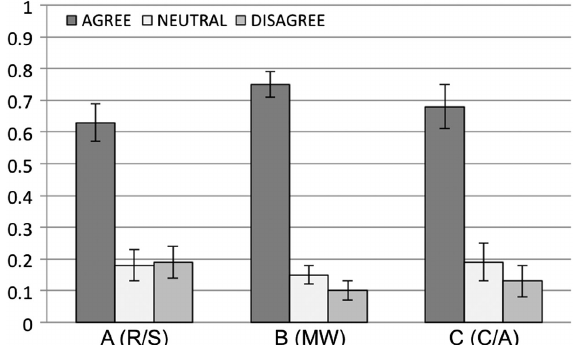
FIG. 6. Postinstruction student responses for courses A , B , and C . Students indicated whether they agreed, disagreed, or felt neutral about the statement: I think quantum mechanics is an interesting subject. N ¼ 69 ( A ), 135 ( B ), and 47 ( C ); error bars represent the standard error on the